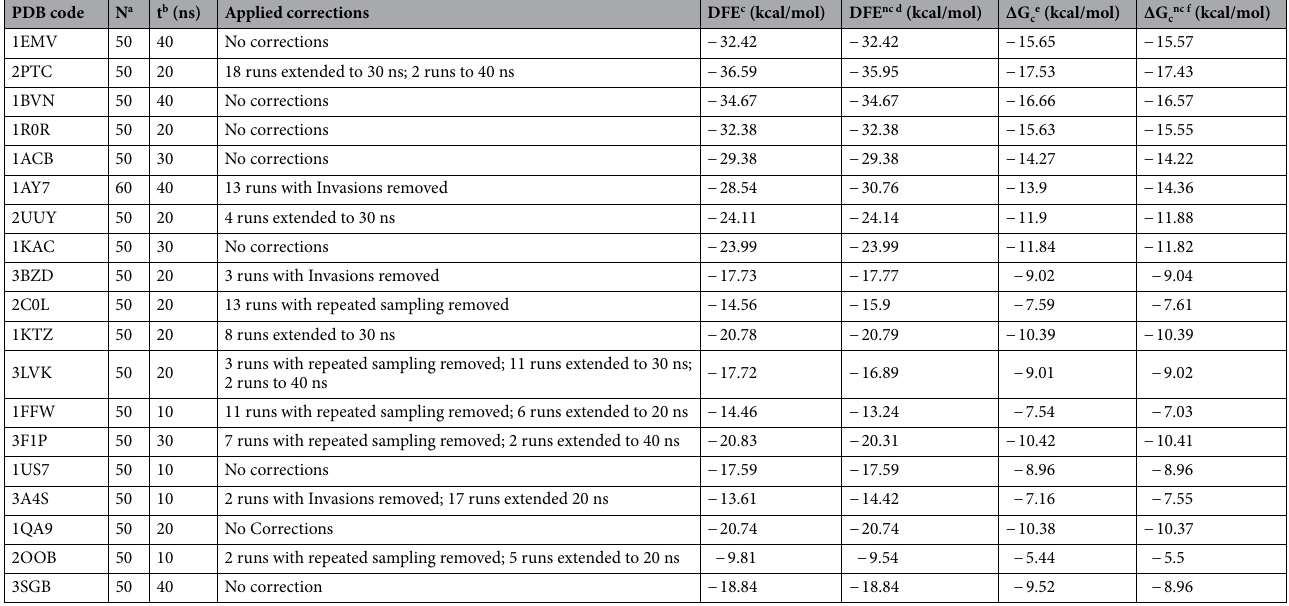
Table 2. Comparison of calculated DFE and binding free energies ∆G c before and after the correction. a The number of runs. b Chemical time of a run before the correction process. c DFE after the correction process. d DFE before the correction process. e Calculated binding free energy after the correction process. f Calculated binding free energy before the correction